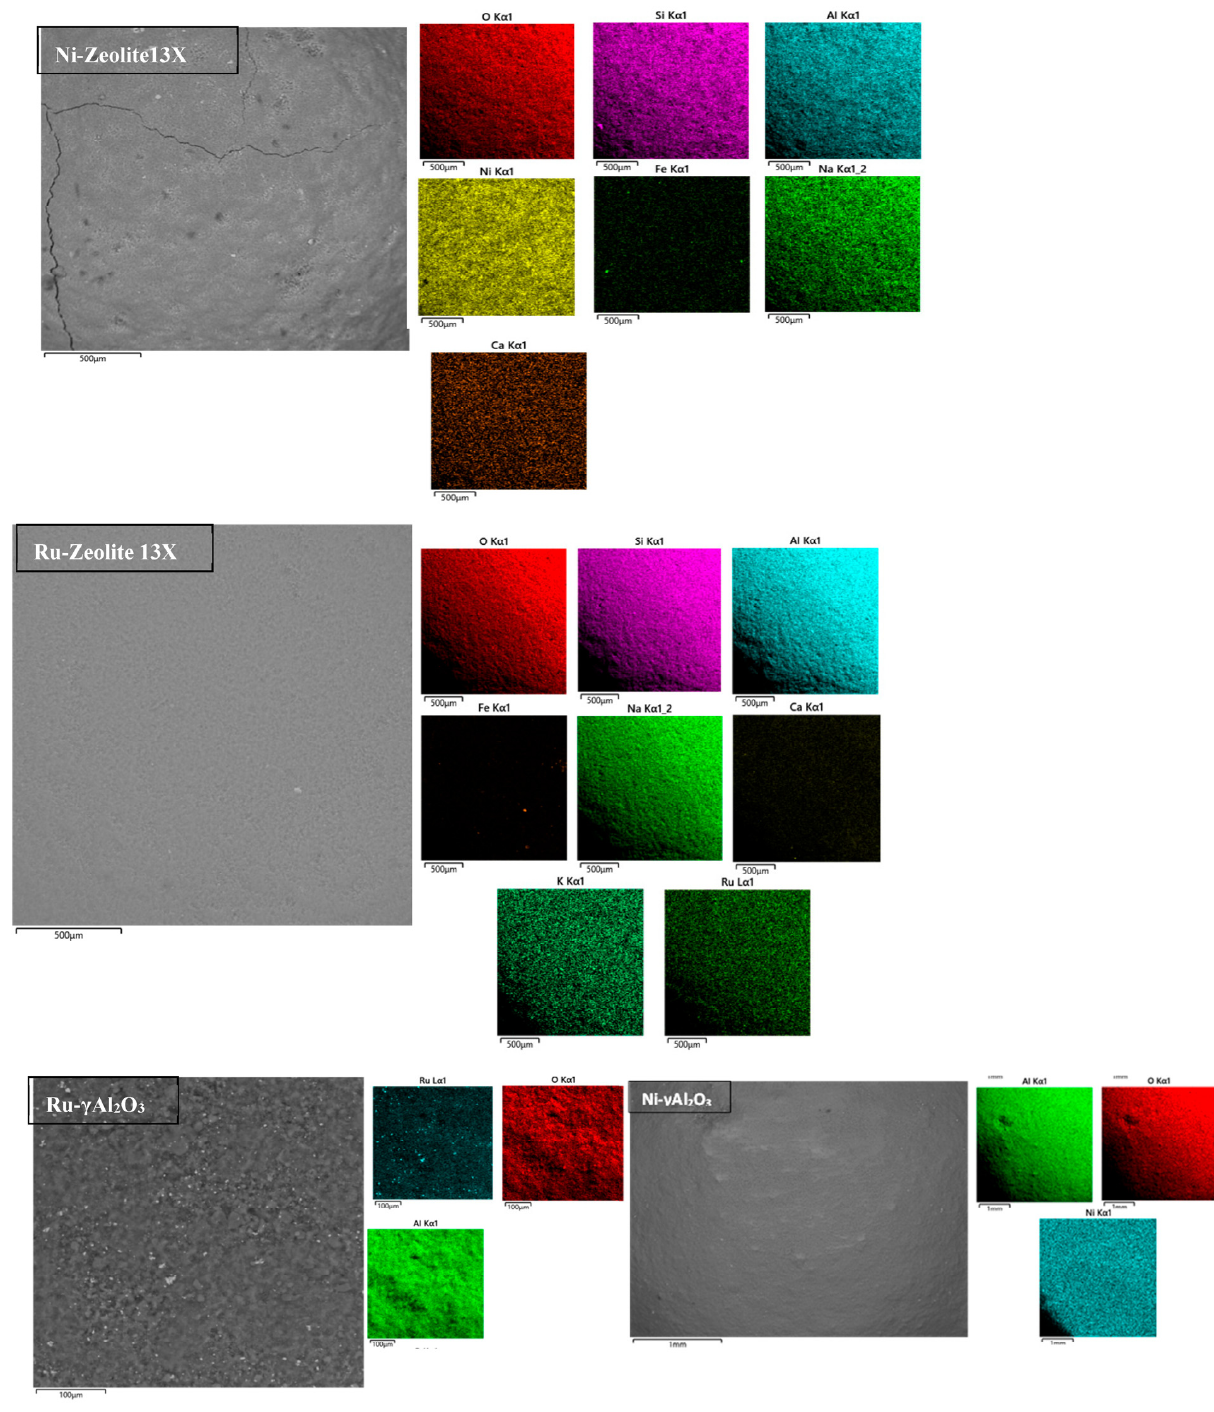
Figure 7. SEM-EDX images of the different catalytic samples. The temperature programmed reduction results are shown in Figure 8.